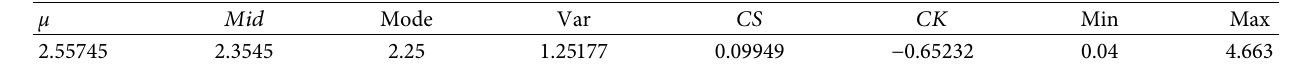
Table 6: Descriptive analysis of airplane windshield data.